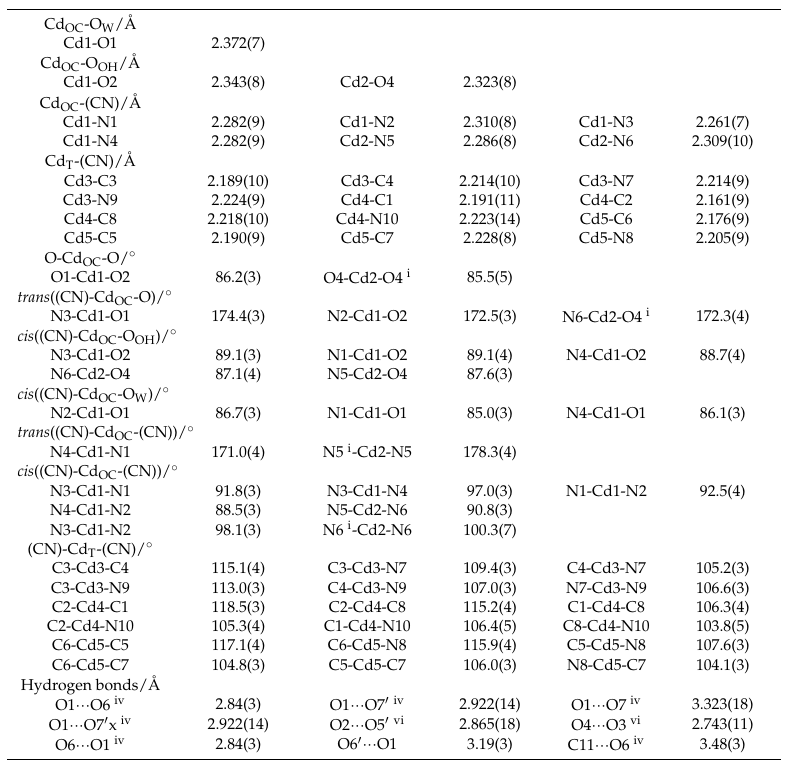
Table 2. The selected bond lengths and angles in I .